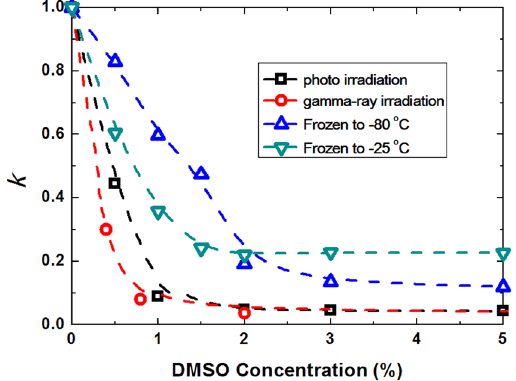
Figure 5. Difference in the protective effect of DMSO. Vertical axis is the relative kinetic constant k = K / K 0 for the generation of DSBs at different concentrations of DMSO, where K 0 is the rate constant in the absence of DMSO. With respect to freezing, ‘quick freezing’ is to − 80 °C, and ‘slow freezing’ is to − 25